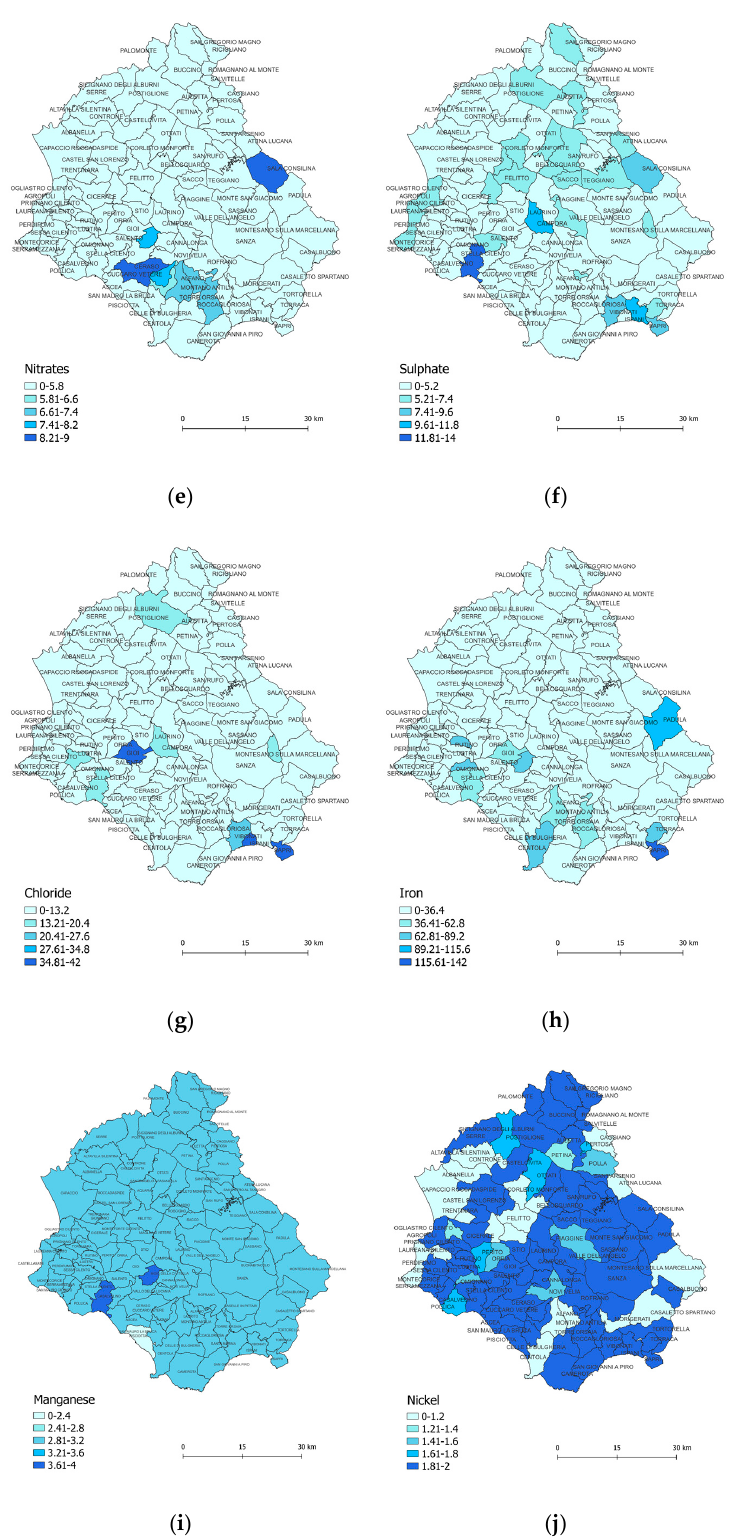
Figure 2. Spatial distribution by Cilento municipalities of tap drinking water elements. Note: ( a ) Spatial distribution of water pH; ( b ) Spatial distribution of total hardness TH; ( c ) Spatial distri- bution of total dissolved solids TDS; ( d ) Spatial distribution of sodium; ( e ) Spatial distribution of nitrates; ( f ) Spatial distribution of sulphate; ( g ) Spatial distribution of chloride; ( h ) Spatial distribution of iron; ( i ) Spatial distribution of manganese; ( j ) Spatial distribution of